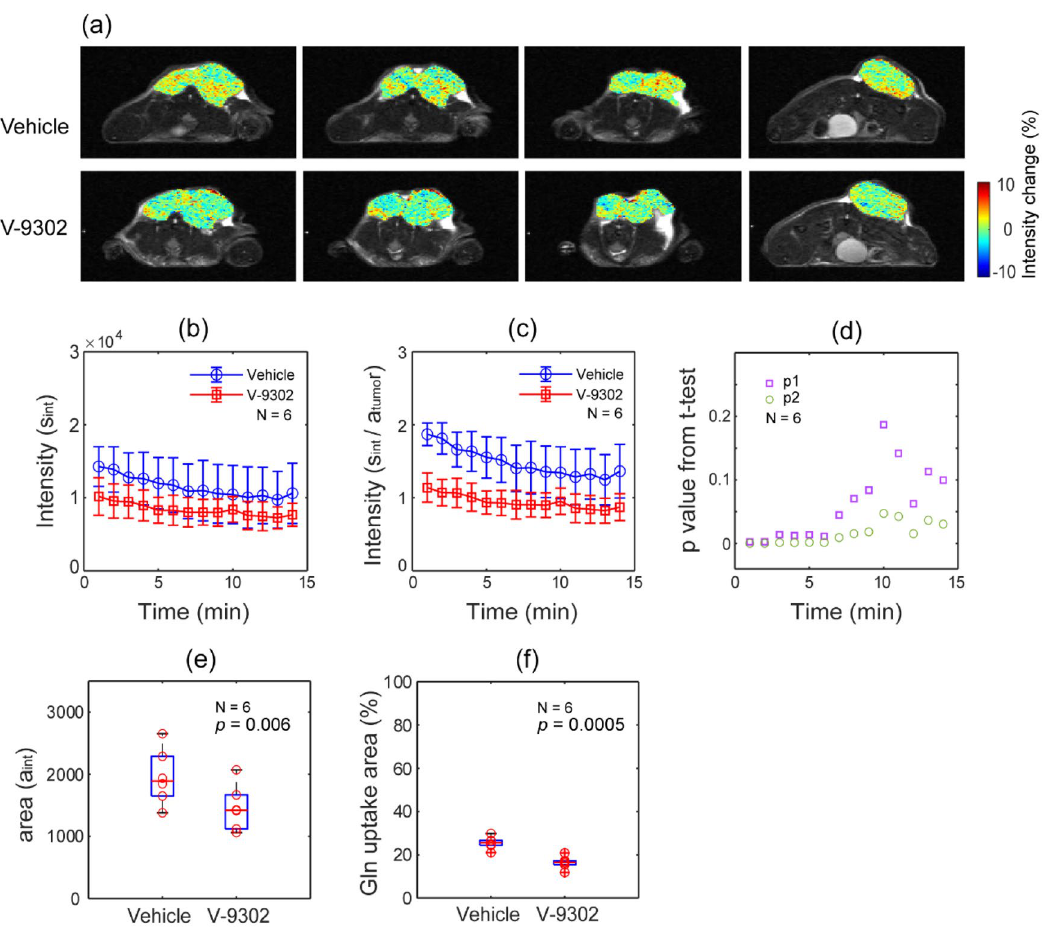
Figure 4. Decreased glutamine uptake in MRI due to the pharmacological inhibition of ASCT2 expression. ( a ) Comparison of representative glutamine MRI images (vehicle vs V-9302 treated) from a single mouse at a similar location. ( b ) The sum of the intensity of pixels that show a change higher than 4% (s int ) is plotted as a function of post-injection time for all six mice. ( c ) Data in ( b ) were divided by the tumor size (a tumor ) to account for the tumor growth during the 3 days between MRI scans. ( d ) p values (p1 from the t -test of s int ( b )) and p2 from the t -test of s int /a tumor ( c ) are presented for the post-injection time. ( e ) The tumor area as a number of pixels that show a change higher than 4% (a int ). It shows reduced glutamine uptake in V-9302-injected mice. ( f ) The relative area of a int in the whole tumor, calculated using the formula (a int /a tumor ) ×